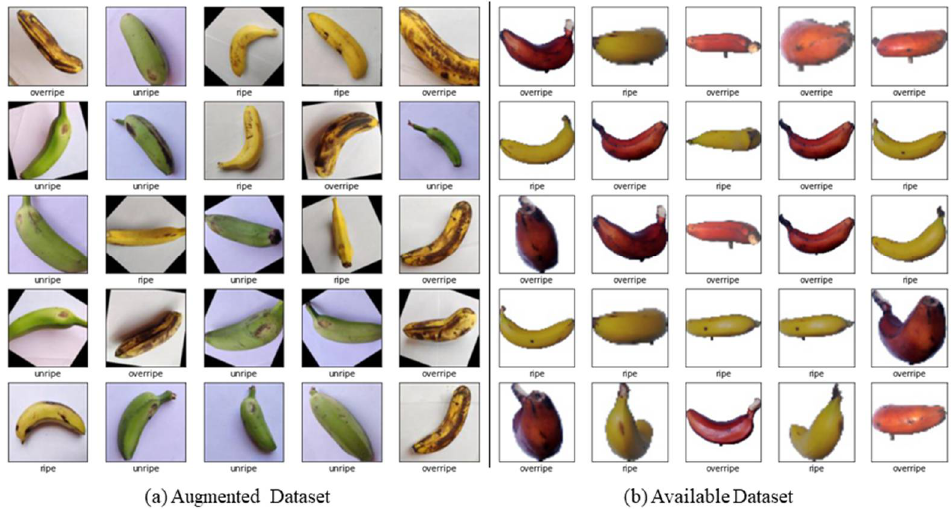
Figure 3. Banana fruit images: ( a ) augmented custom dataset and ( b ) Fruit 360 dataset, Atapted with permission from Ref. [23]. Copyright © 2017-2021 Mihai Oltean. Table 2. Original, augmented, and Fruit 360 dataset information.